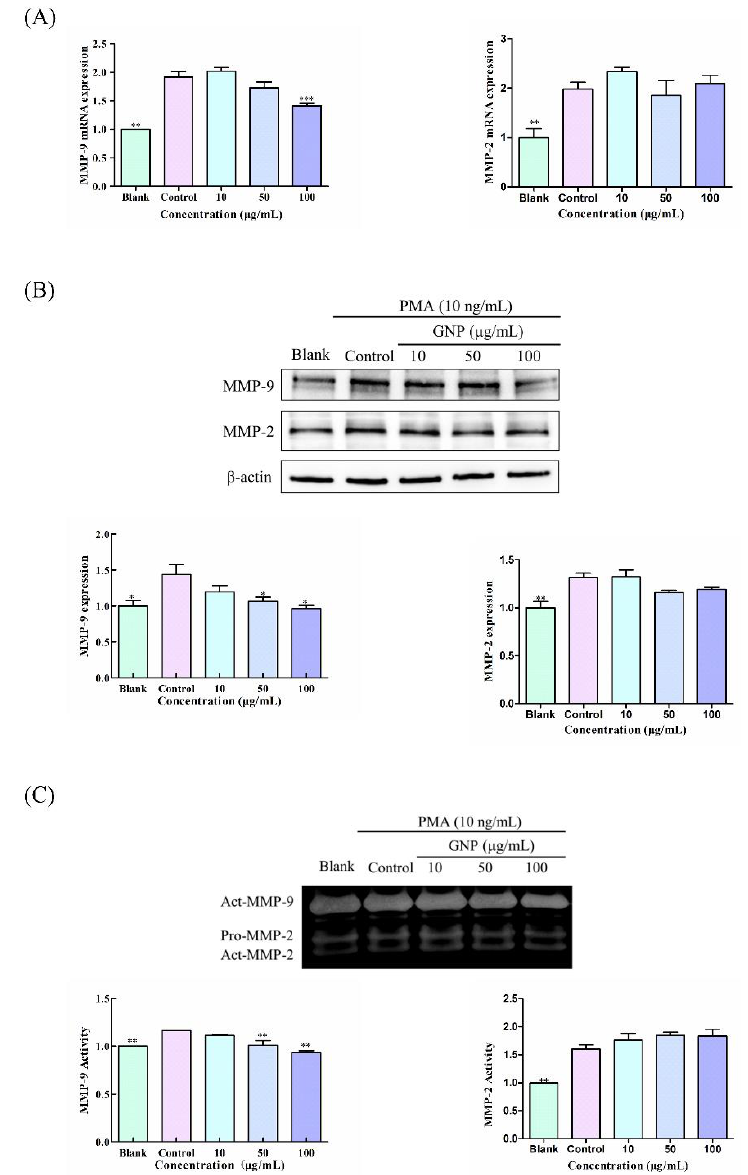
Figure 3. ( A ) The MMP-9 and MMP-2 mRNA levels in HT1080 cells. β -actin was the loading control. ( B ) The protein of MMP-9 and MMP-2 level in HT1080 cells. β -actin was the loading control. ( C ) The enzymatic activity of MMP-9 and MMP-2 in HT1080 cells supernatant. Data are shown as mean ± SD ( n = 3). p < 0.05 (*), p < 0.01 (**), p < 0.001 (***) compared with PMA alone treated control